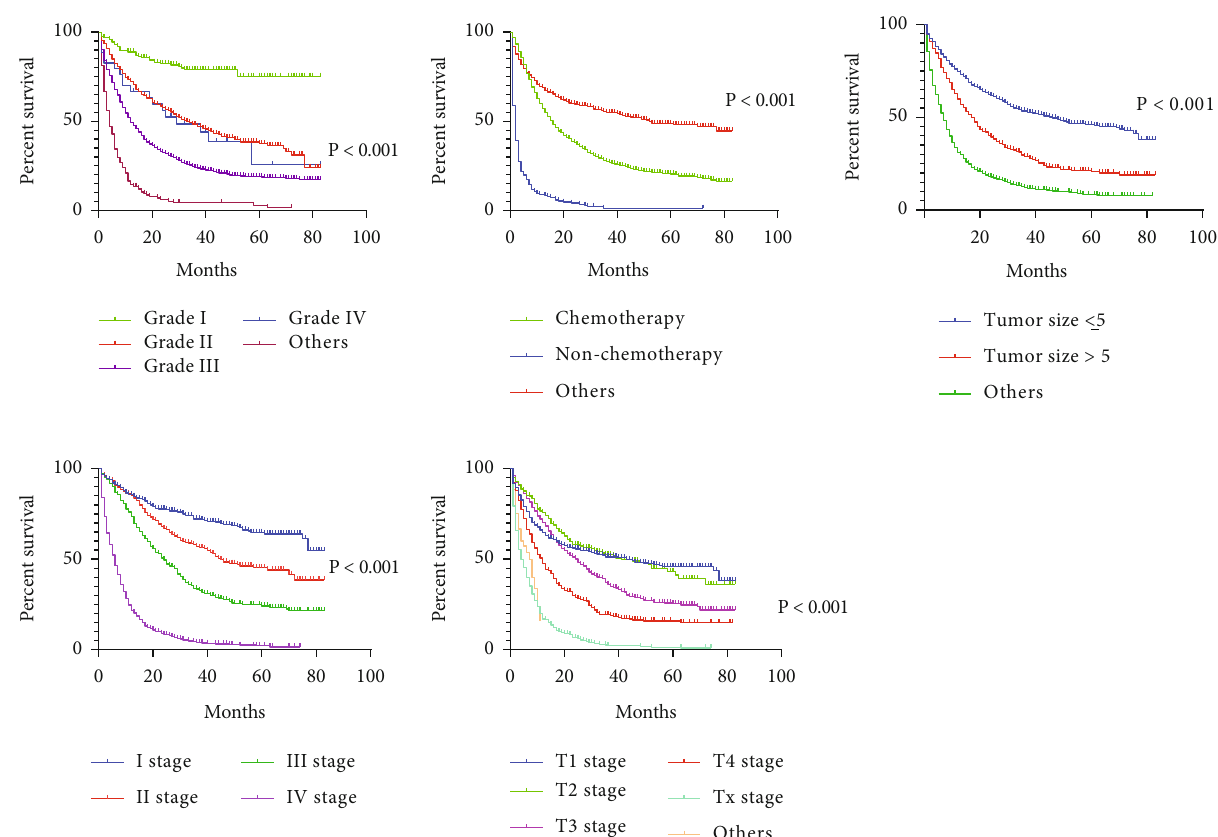
Figure 3: Survival analysis of independent risk factors a ff ecting the prognosis of patients with gastric